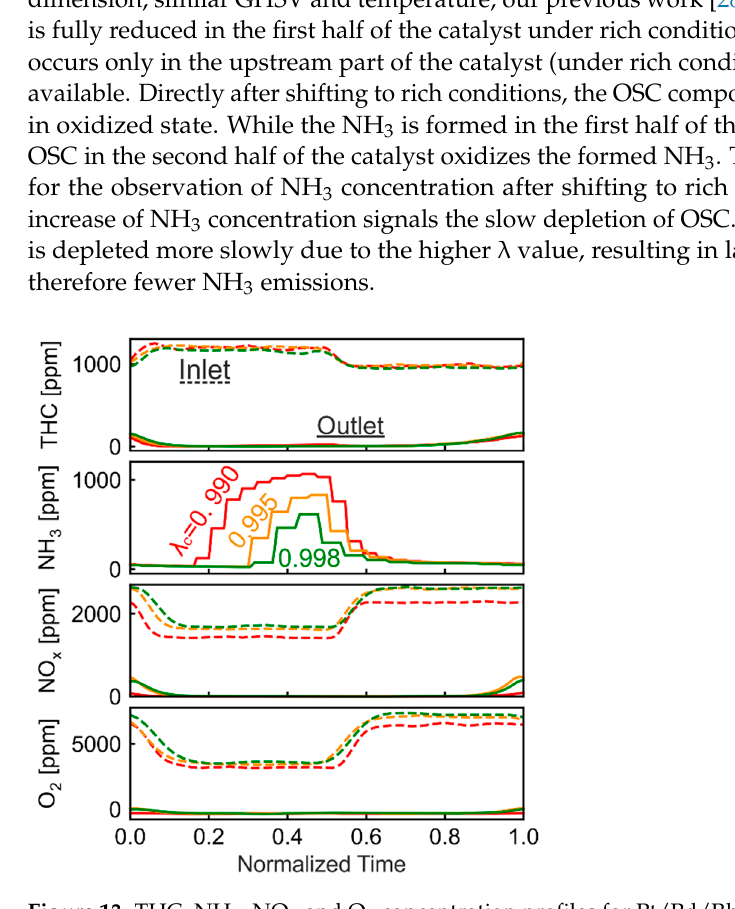
Figure 13. THC, NH 3 , NO x and O 2 concentration profiles for Pt/Pd/Rh catalyst during oscillations with λ c = 0.990, 0.995 and 0.998 (corrected λ with λ c = 0.990, 0.995 and 0.998 (corrected λ ).